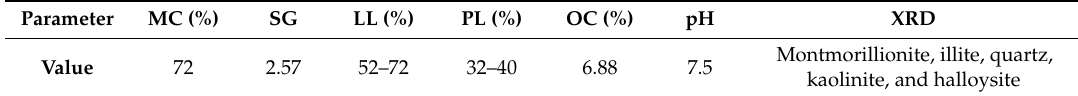
Table 1. Physical properties of marine clay soil.